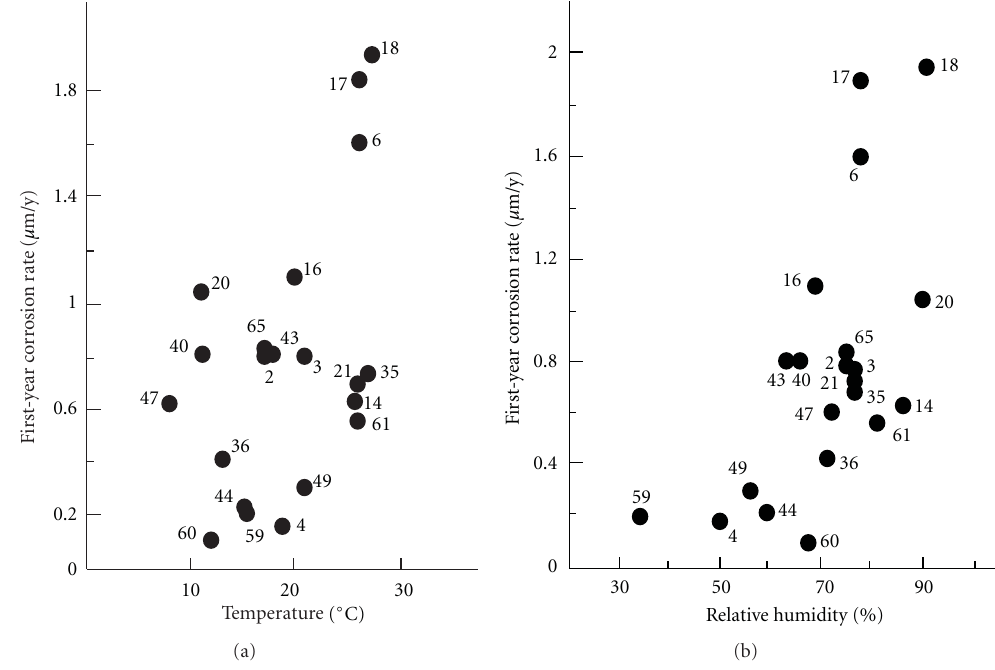
Figure 8: First-year copper corrosion rate versus temperature (a) and relative humidity (b) in rural